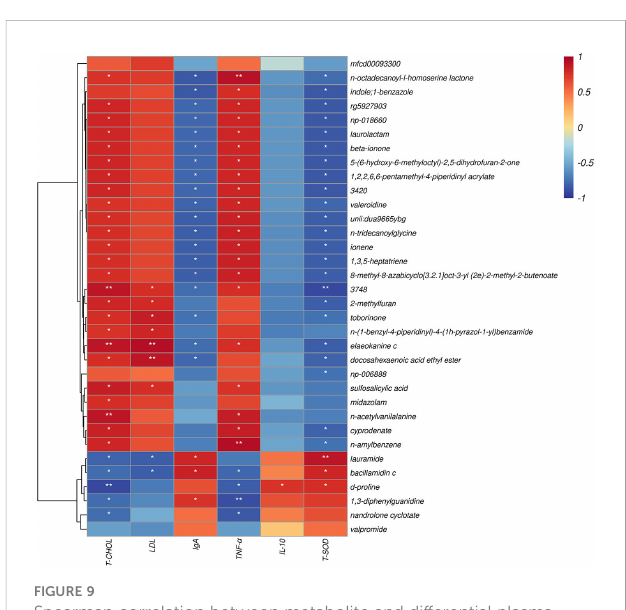
FIGURE 9 Spearman correlation between metabolite and differential plasma related indicators (6h). The abscissa is the plasma immune and antioxidant markers and the ordinate is the signi fi cant blood metabolite. Red denotes a positive correlation; blue denotes a negative correlation. *P < 0.05, **P < 0.01